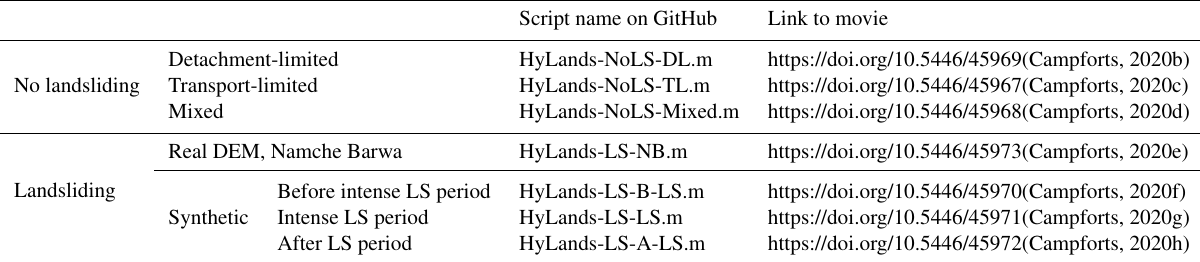
Table 2. Simulation movies and script names.